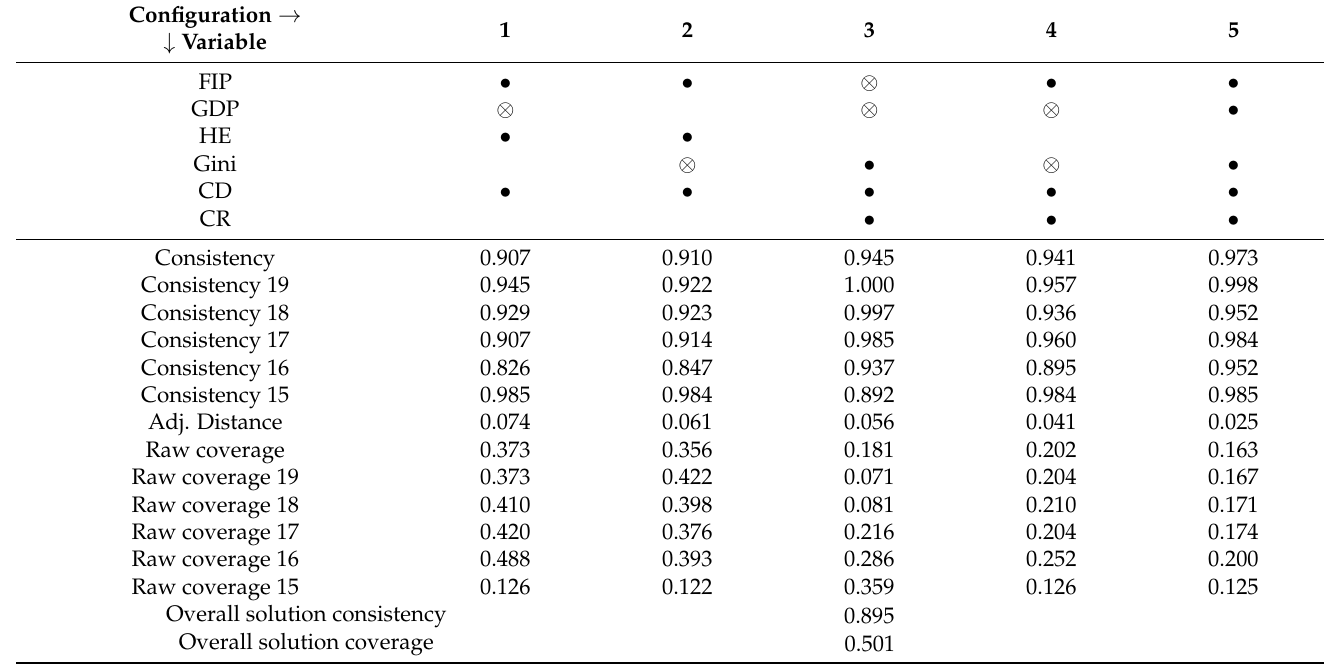
Table 5. Configurations for high energy consumption